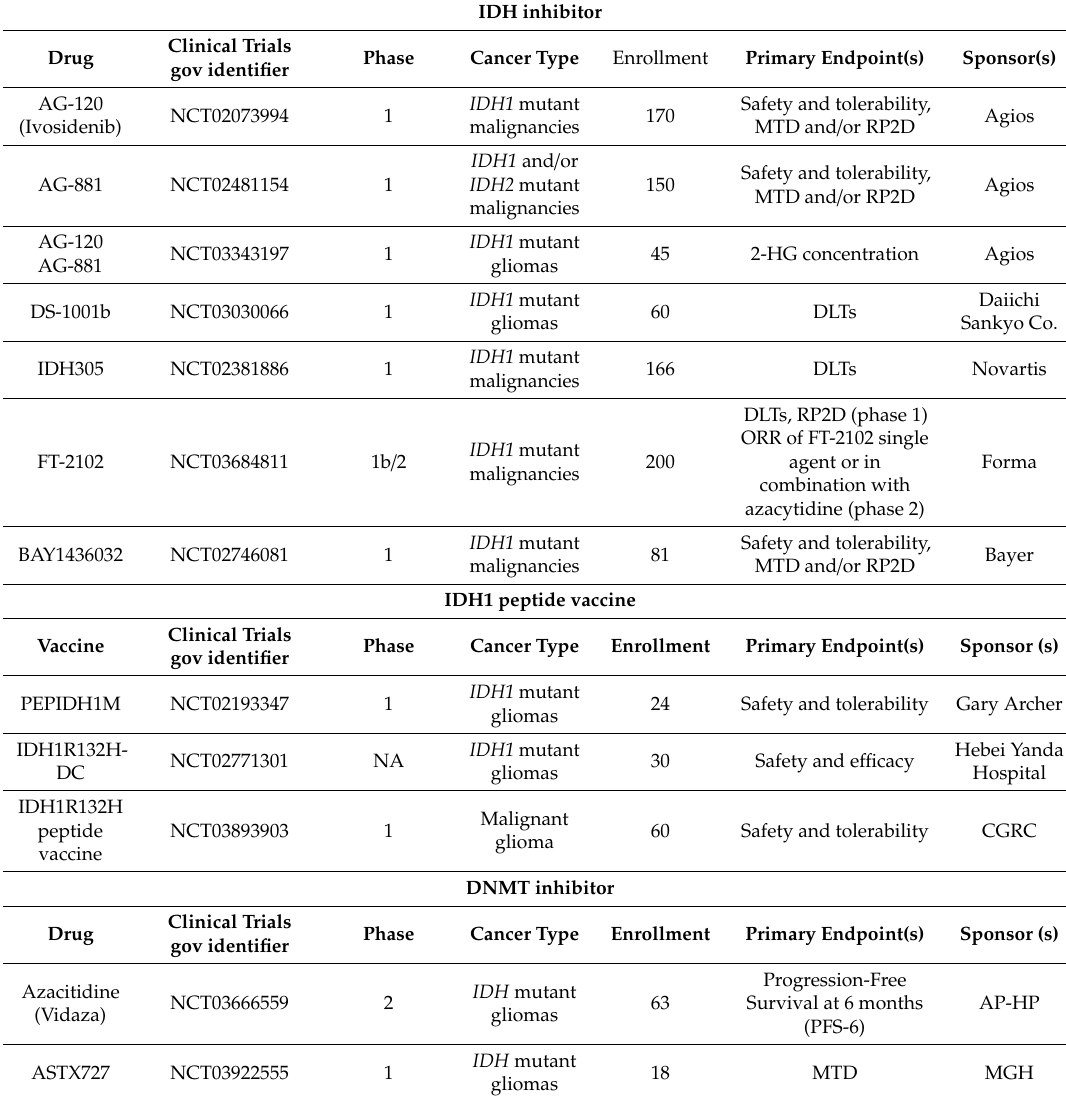
Table 1. Ongoing epigenetic trials in IDH -mutant